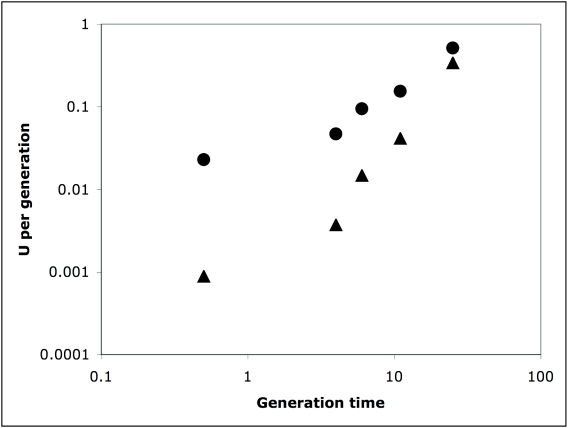
The estimated mutation rate per generation in mtDNA versus generation time.The triangles are for the equal rates model the circles for the gamma rates model assuming a shape parameter of 1.0.